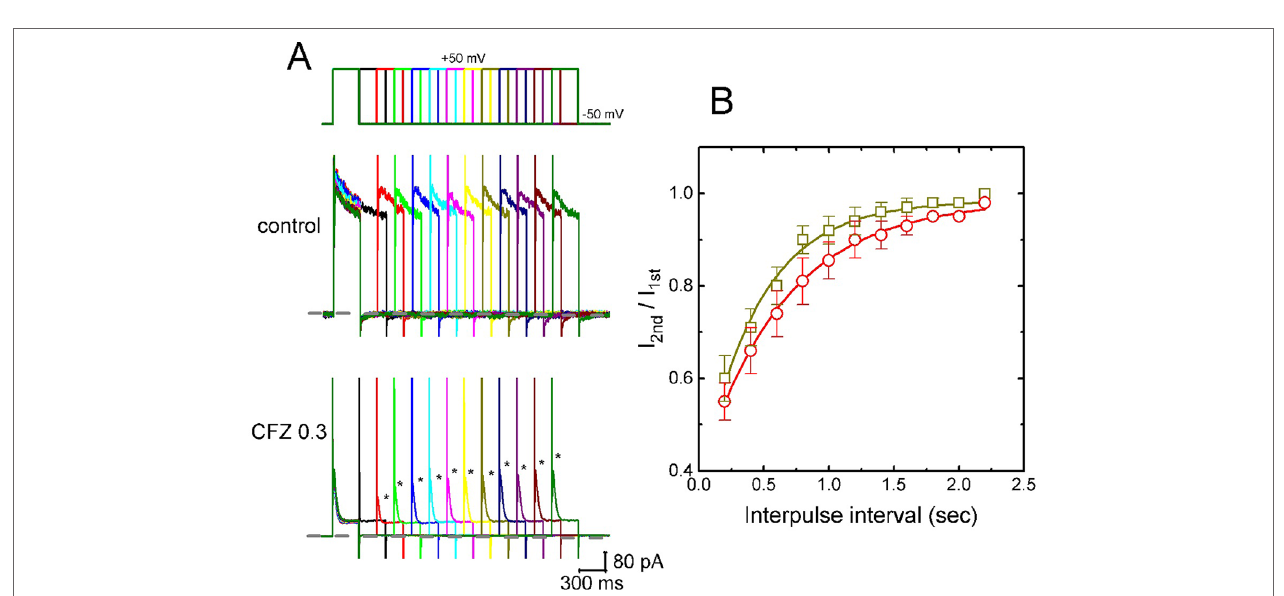
FIGURE 4 | Time course of the recovery of I K(DR) in the presence of 0.3 and 1 µM CFZ. In these experiments, GH 3 cells, bathed in Ca 2+ -free Tyrode’s solution, were depolarized from −50 to +50 mV with a duration of 300 ms and different interpulse durations were applied. (A) Representative I K(DR) traces in the absence (upper) and presence (lower) of 0.3 µM CFZ elicited by a two-pulse protocol with different interpulse durations (indicated in the upper part). Dashed line indicates the zero current level. (B) Time courses of recovery from I K(DR) inactivation caused by 0.3 µM CFZ (open squares) and 1 µM CFZ (open circles), respectively. Smooth curves in the presence of different CFZ concentrations were fitted by single exponential. Each point represents the mean ± SEM (n = 8). Asterisks indicate the peak I K(DR) elicited by different interpulse